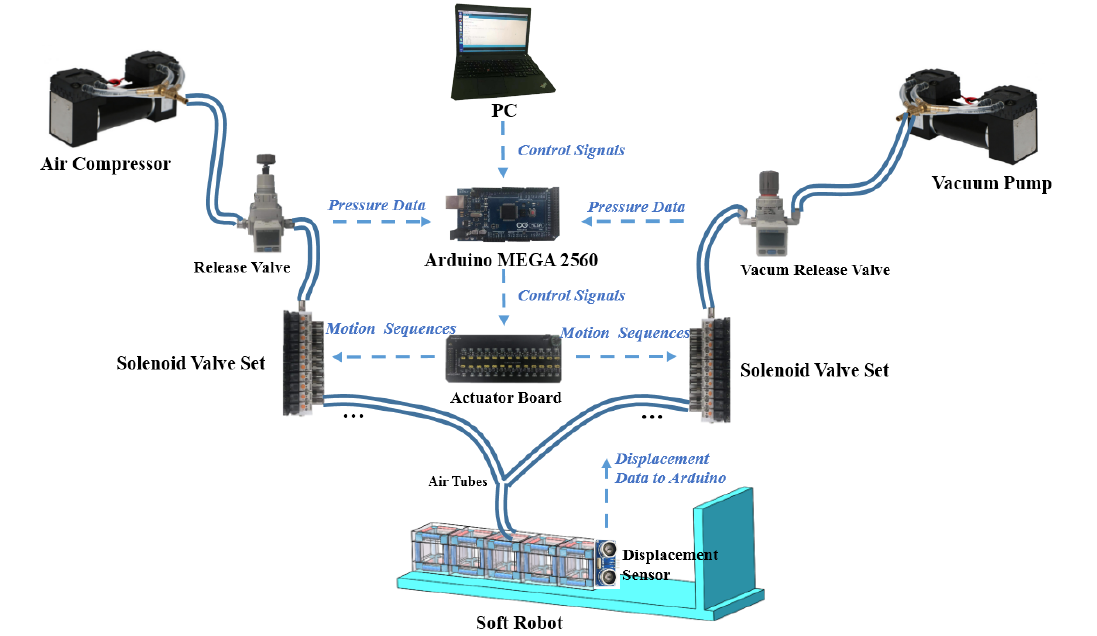
Figure 9. Experiment platform and system schematic diagram.